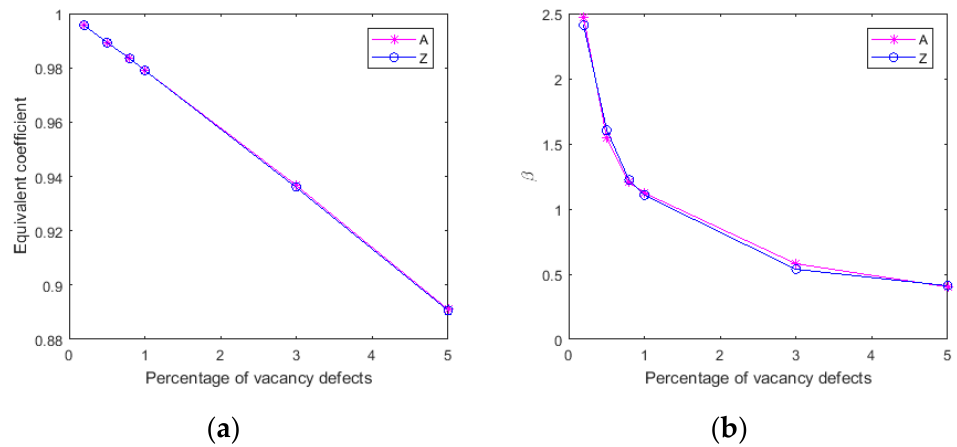
Figure 17. The robustness of graphene with random distributed vacancy defects. ( a ) is for the equivalent coefficient, ( b ) is for β .